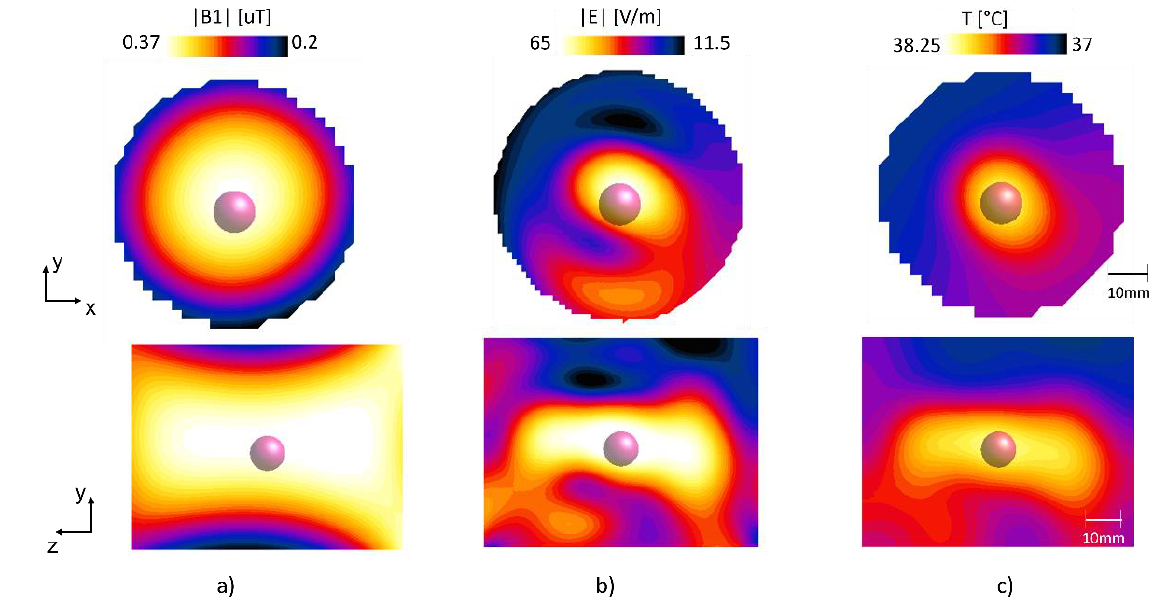
Figure 7. The computed ( a ) |B|-field, ( b ) |E|-field and ( c ) temperature map for the cylindrical phantom.